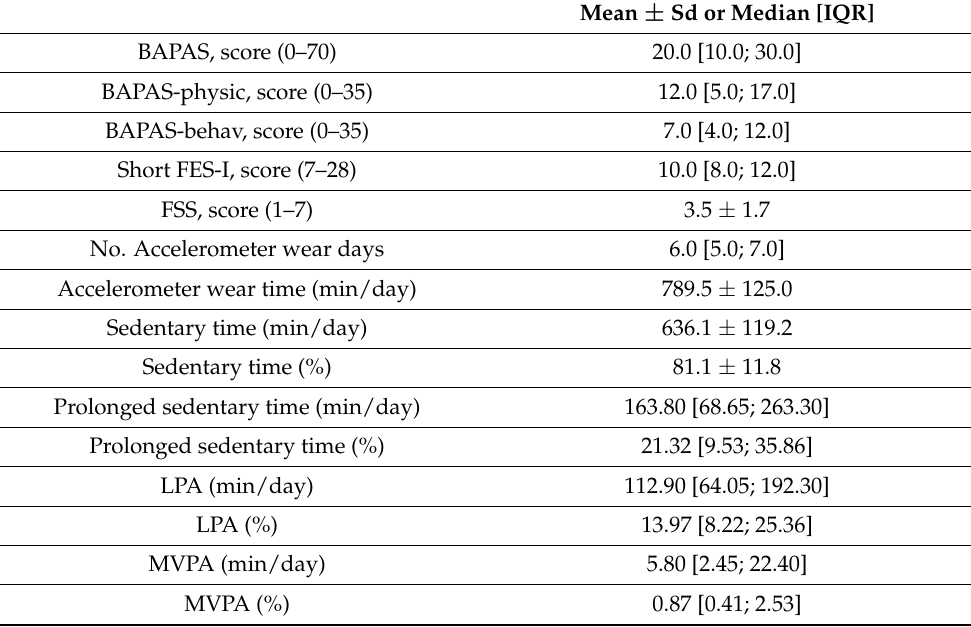
Table 2. Results of the barriers, fear of falling and fatigue scales and the activity monitoring measure- ment ( n =